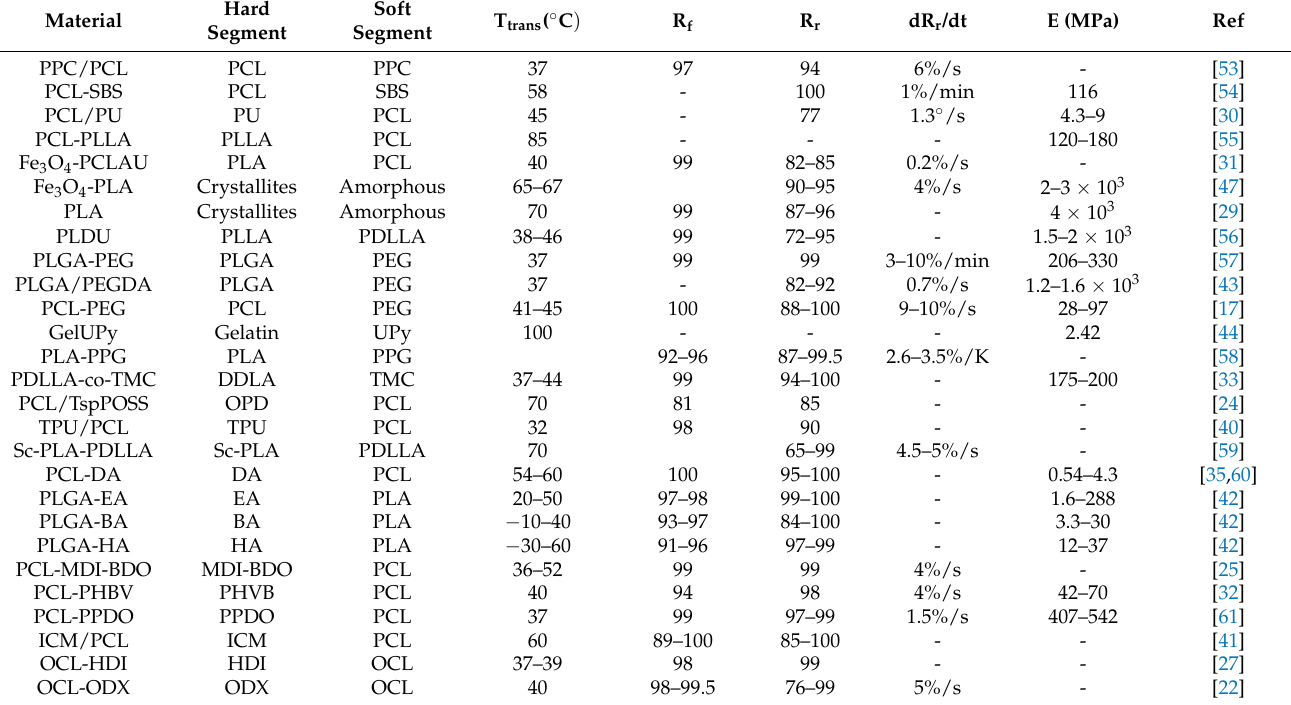
Table 1. Thermomechanical properties and shape memory performance of BSMPs with different combinations of segments.